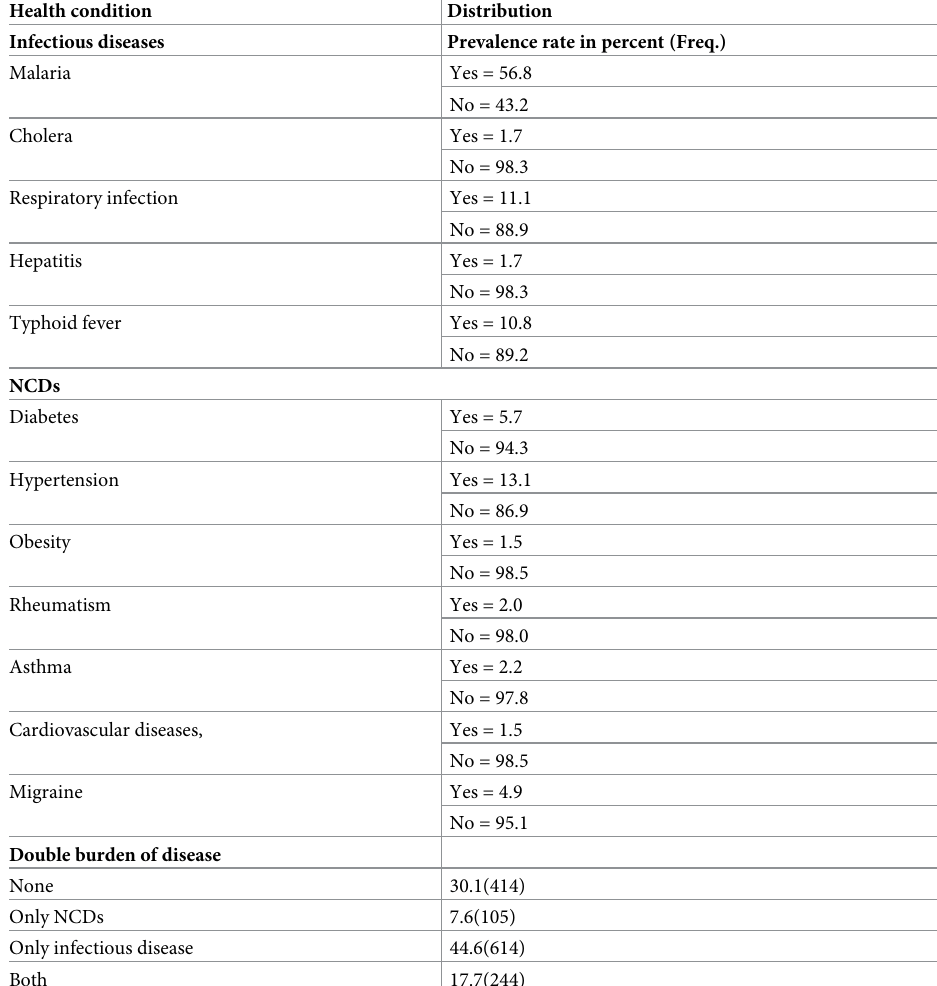
Table 2. Distribution of infectious diseases and chronic health